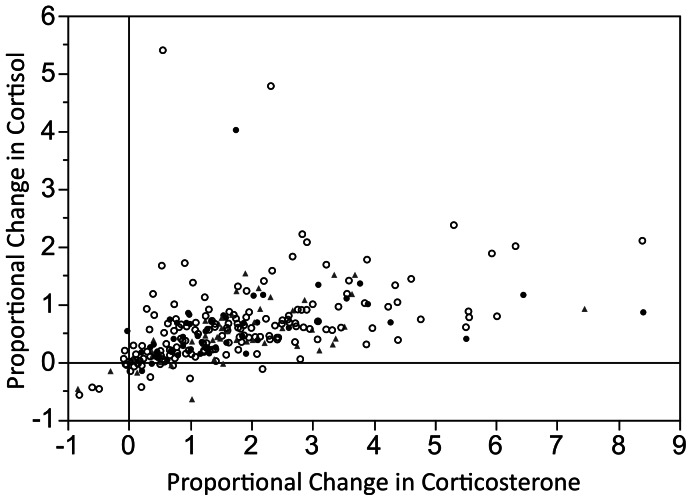
Association between fetal corticosterone and cortisol synthesis by delivery type.Proportional change in corticosteroid concentrations after passage through the fetus ([A-V]/V) for 163 vaginal deliveries (Vag: open circles), 53 scheduled Caesarian sections (C: solid circles), and 49 Emergent C-sections (EC: shaded triangles). Linear positive association, and range of response, are reported in the text.